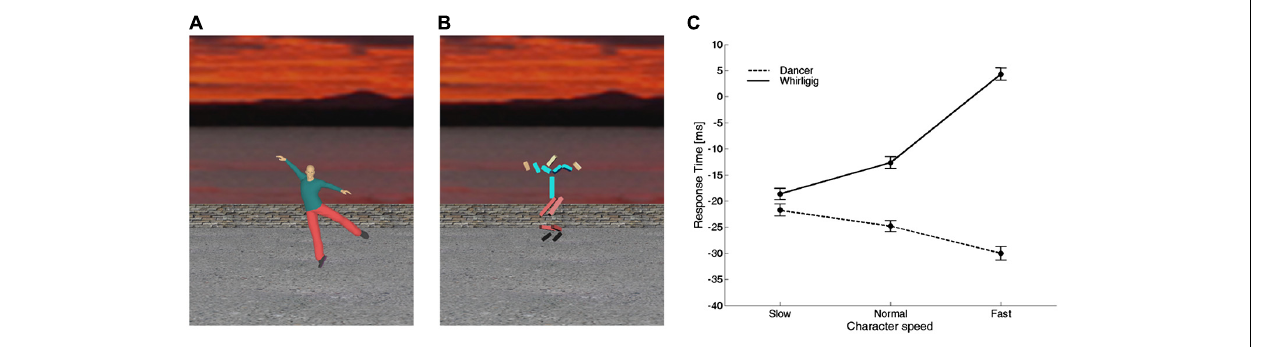
dancer. In different sessions, dancer and whirligig movements could be played at the normal recorded speed, at slow or fast speeds (corresponding to 0.5 and 1.5 times the normal one, respectively). (C) Average ( ± 95% confidence intervals over all participants) response times for the slow, normal, and fast speeds. Modified with permission from Carrozzo and Lacquaniti